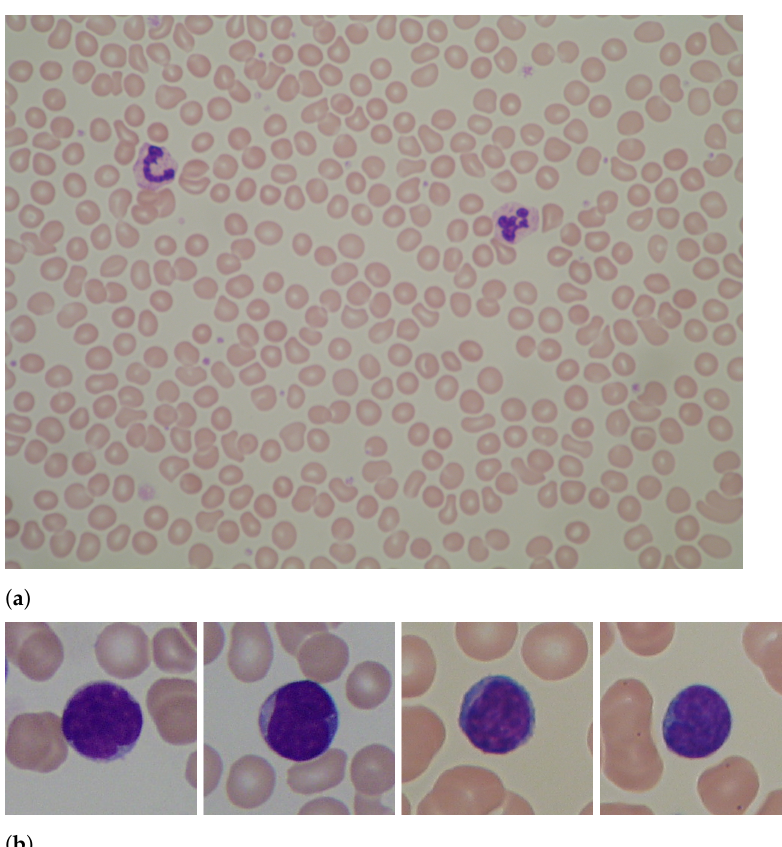
Figure 2. Example of the whole PBS image and the single cropped WBC. ( a ) Original PBS image was acquired from a healthy subject (source ALL-IDB1). ( b ) From the left, two lymphoblasts and two lymphocytes (source